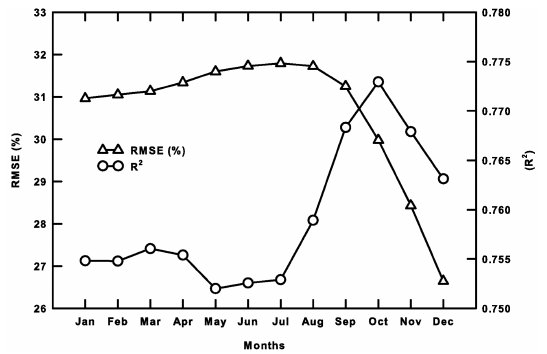
Figure 6. Logistic model performance in terms of RMSE (%) and R 2 over every month of the year.